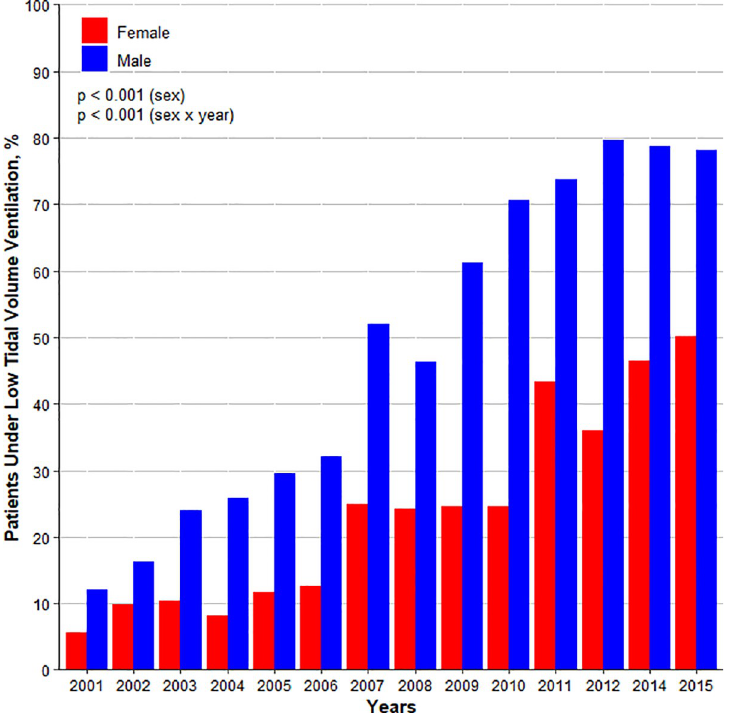
Fig 2. Percentage of patients receiving low tidal volume ventilation. Low tidal volume ventilation defined as a median of tidal volume in the first 48 hours of ventilation � 8 ml/kg PBW. The overall difference on the use of low tidal volume ventilation among females and males corrected by the years is -26.7% (-28.8 to -24.6)%; p < 0.001. There is an interaction between dataset and sex ( p = 0.004), and dataset and sex x year interaction ( p = 0.004).